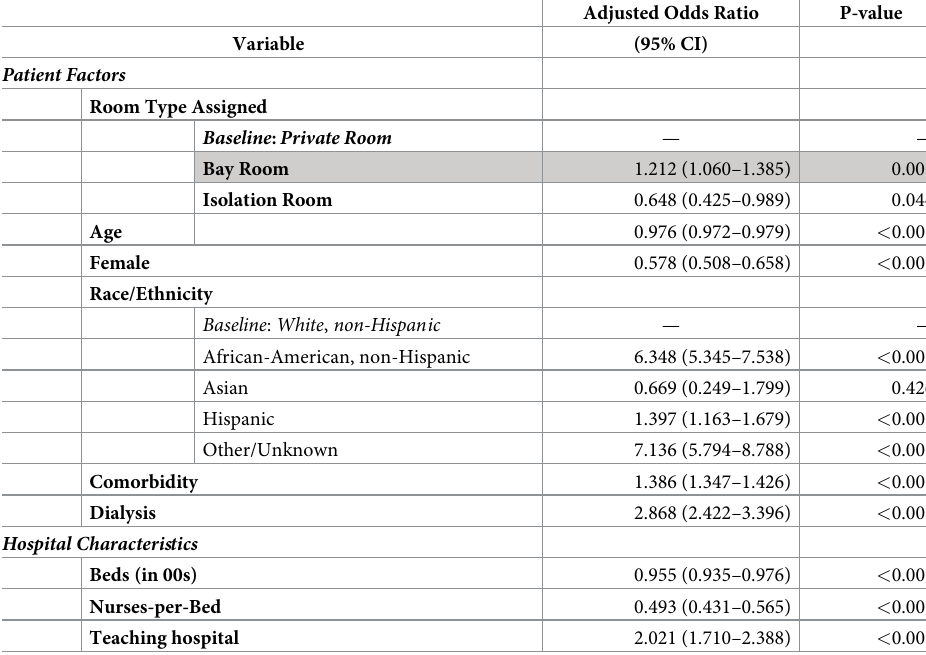
Table 3. Impact of room assignment and other variables on CLABSI risk.